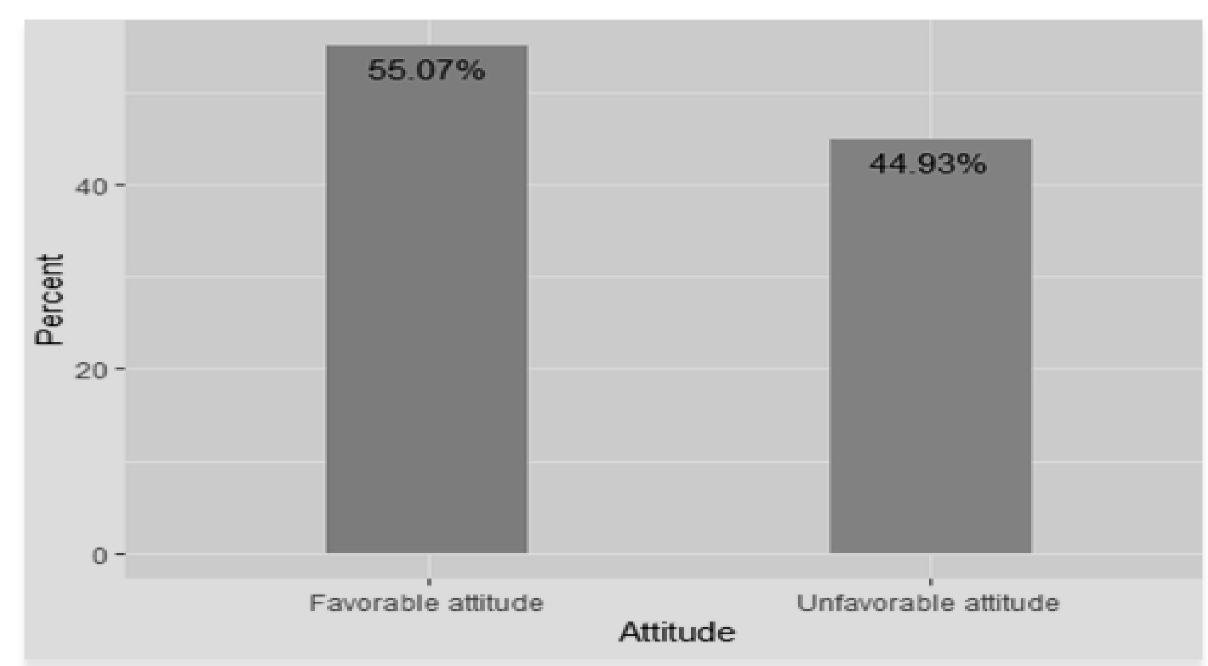
Fig 1. Level of attitude towards diabetes mellitus among adult non-diabetic community members of Gondar city, Ethiopia 2019.